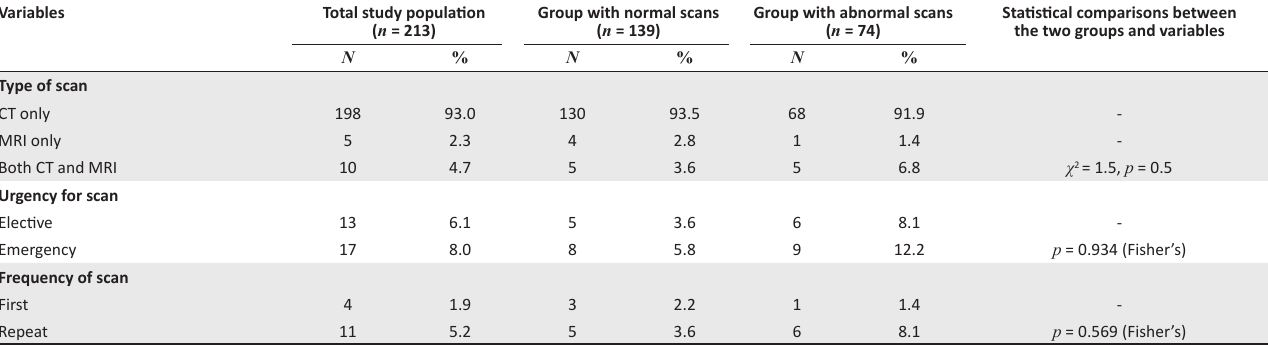
TABLE 2: Frequency distribution of the scan characteristics of the study population. Variables Total study population ( n =